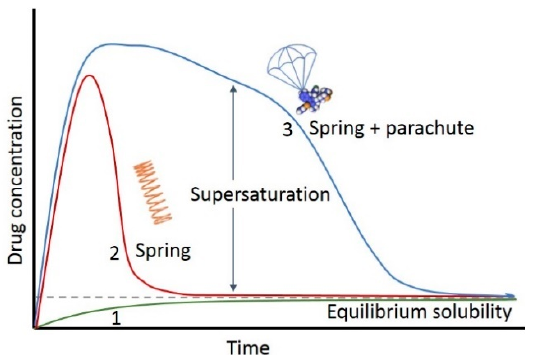
Figure 1. Schematic drug concentration–time profiles illustrating the supersaturation and precipita- tion process (“spring and parachute approach”) of a hypothetical drug. Profile 1: the dissolution of the most stable crystalline phase; Profile 2: the dissolution of a higher energy ‘‘spring’’ form of the drug in the absence of precipitation inhibitors; Profile 3: the dissolution of a higher energy “spring” form of the drug in the presence of precipitation inhibitors that act as a ‘‘parachute’’.